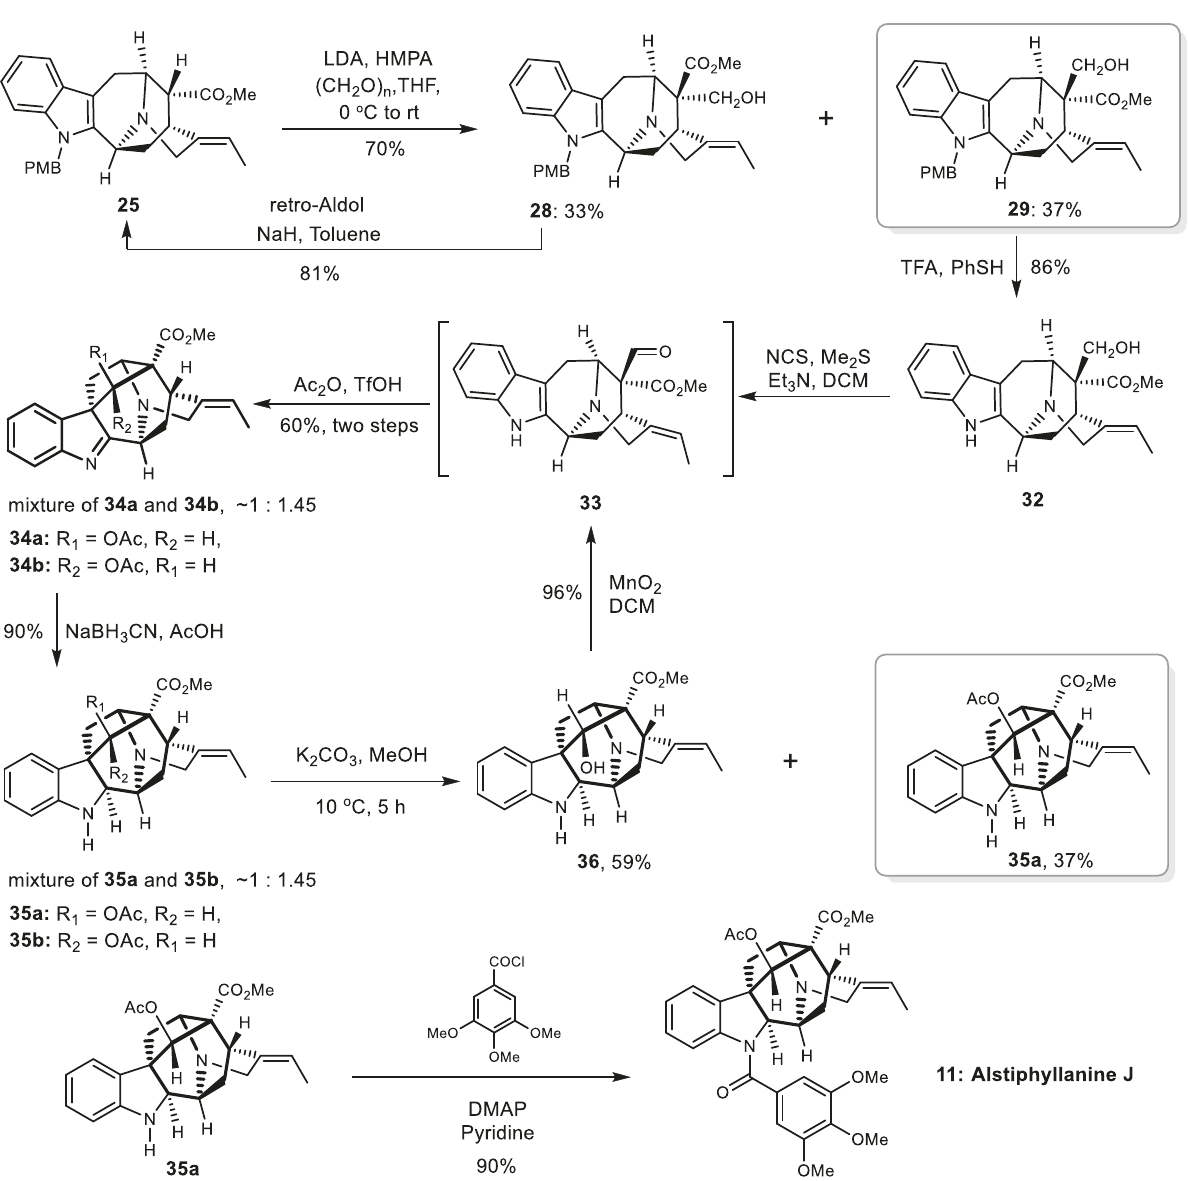
Fig. 7 Synthesis of alstiphyllanine J. Alstiphyllanine J has a 19- Z -ole fi n moiety. DMAP N , N